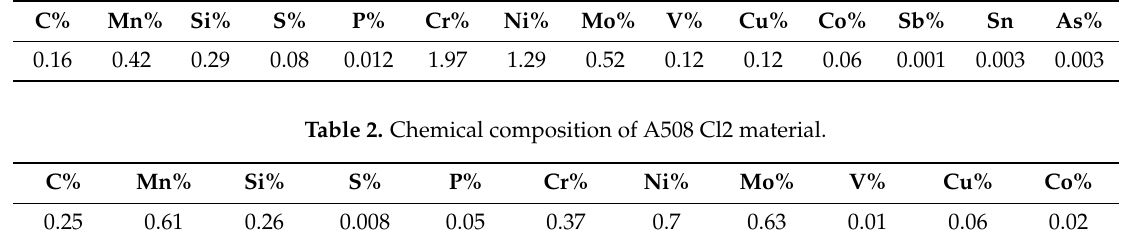
Table 1. Chemical composition of 15Kh2NMFA material.